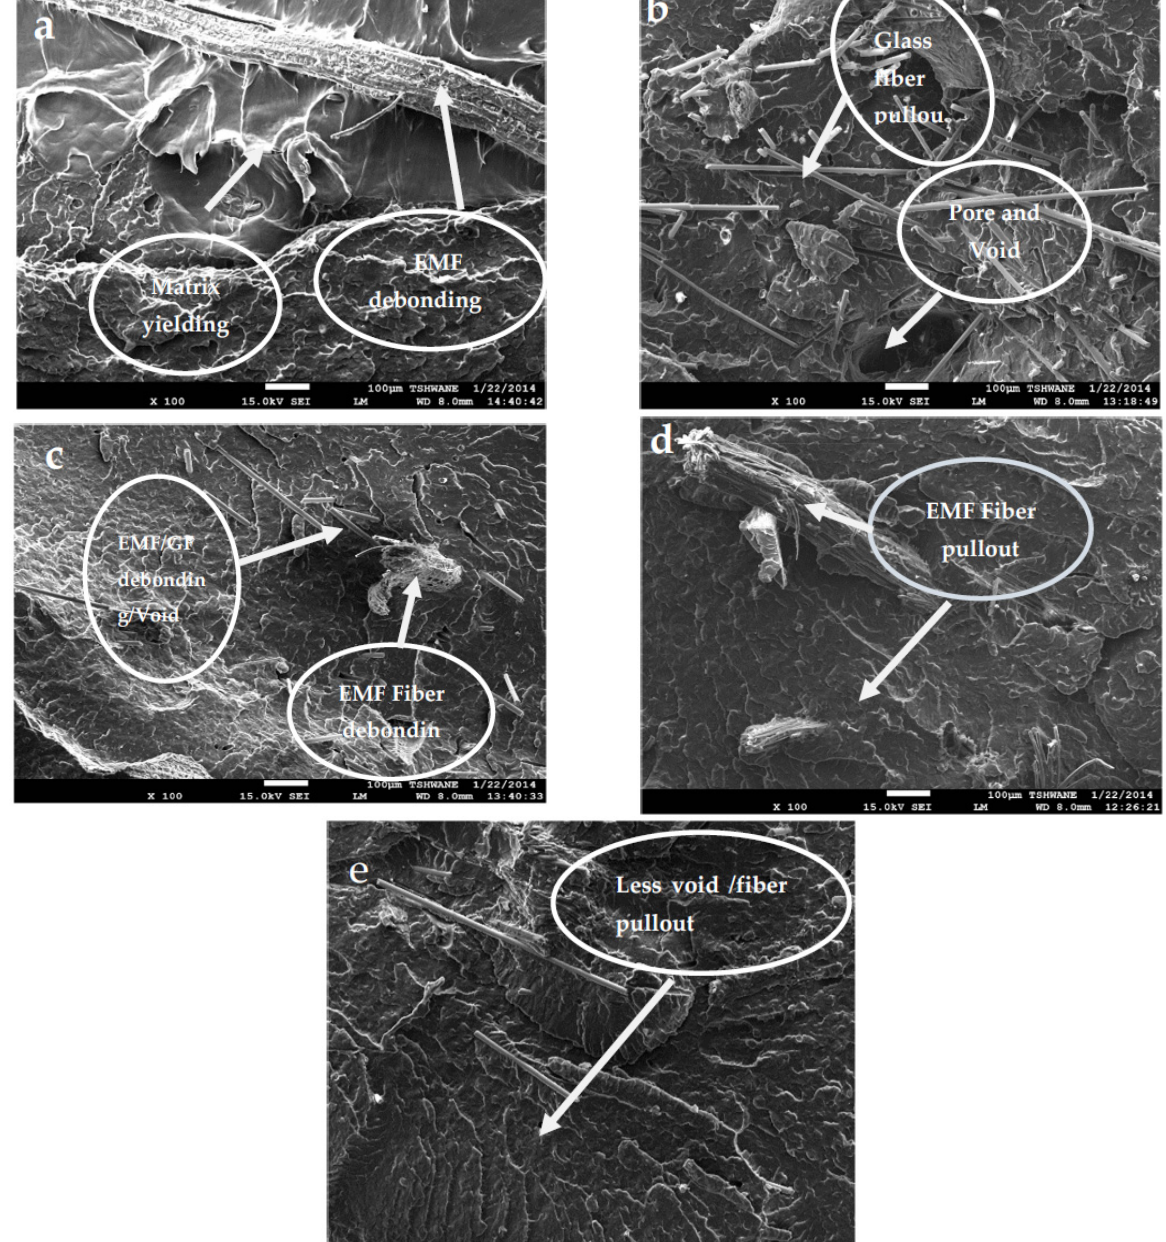
Figure 11. Morphological characterization of single and hybrid reinforced composites: ( a ) EMF1; ( b ) GF2; ( c ) EMF/GF3; ( d ) EMF/GF4; ( e ) EMF/GF5.